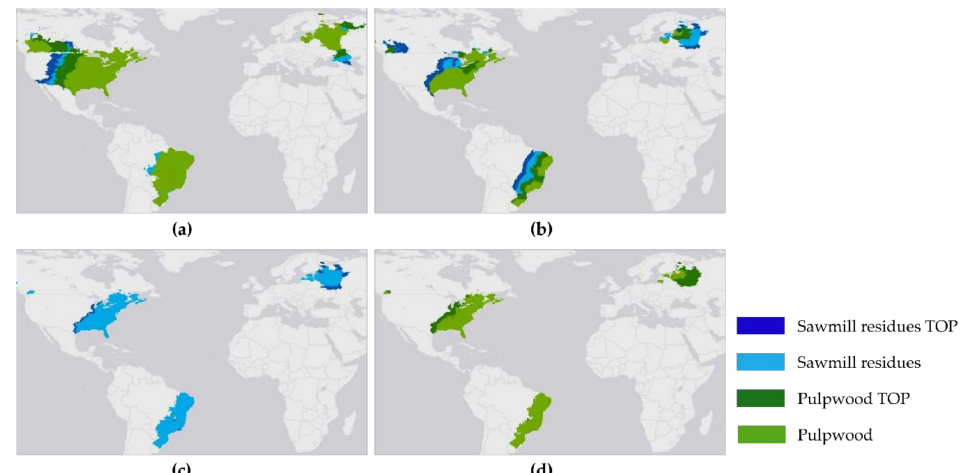
Figure 7. Maximum supply area of pellets made from sawmill residues and pulpwood when applying ( a ) GHG emissions savings; ( b ) 80% GHG emission savings; ( c , d ) € 150 / t pellets CIF ARA for wood pellets, corresponding to € 171 t / pellets CIF ARA for torrefied pellets, in proportion to the higher energy